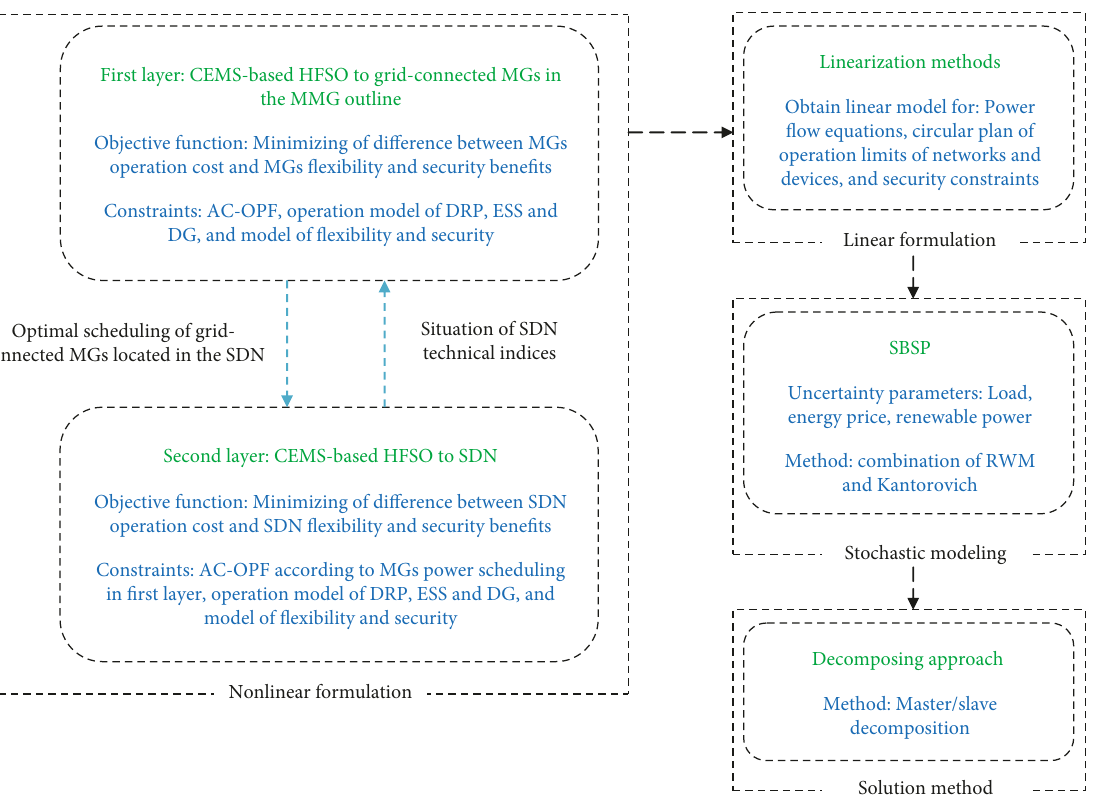
Figure 1: The proposed two-layer CEMS-based